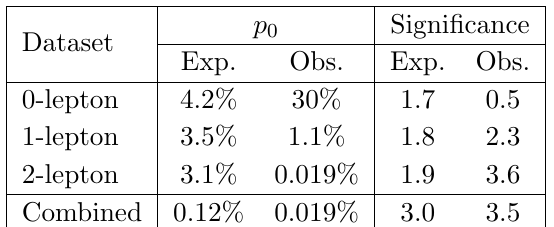
Signi(cid:12)cance